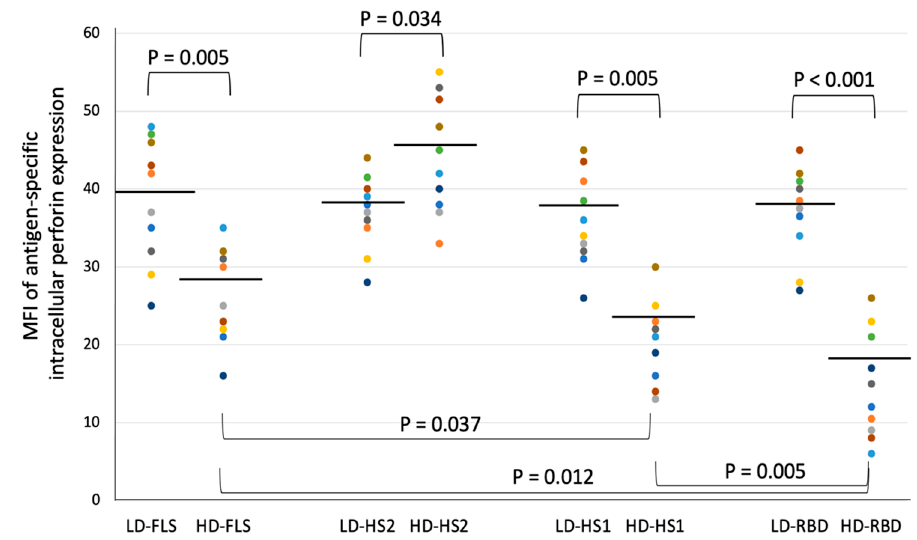
Figure 5. The antigen-specific intracellular perforin expression in CD8+ T cells in response to low dose (LD) or high dose (HD) FLS (full-length spike)-, HS1 (S1 of SARS-CoV-2)-, HS2 (S2 of SARS-CoV-2)-, or RBD (receptor-binding domain)-presenting DCs on day four of incubation in the in vitro DC-T model in 10 subjects. Horizontal lines indicate the data as mean values. The doses of antigens were calculated according to the relative molecular weights to achieve nearly equivalent amounts of protein molecules: LD-RBD as 40 ng/mL and HD-RBD as 200 ng/mL, LD-HS1 as 110 ng/mL and HD-HS1 as 550 ng/mL; LD-HS2 as 80 ng/mL and HD-HS2 as 400 ng/mL; LD-FLS as 200 ng/mL and HD-FLS as 1000 ng/mL; p -values were determined by Wilcoxon signed-rank test.